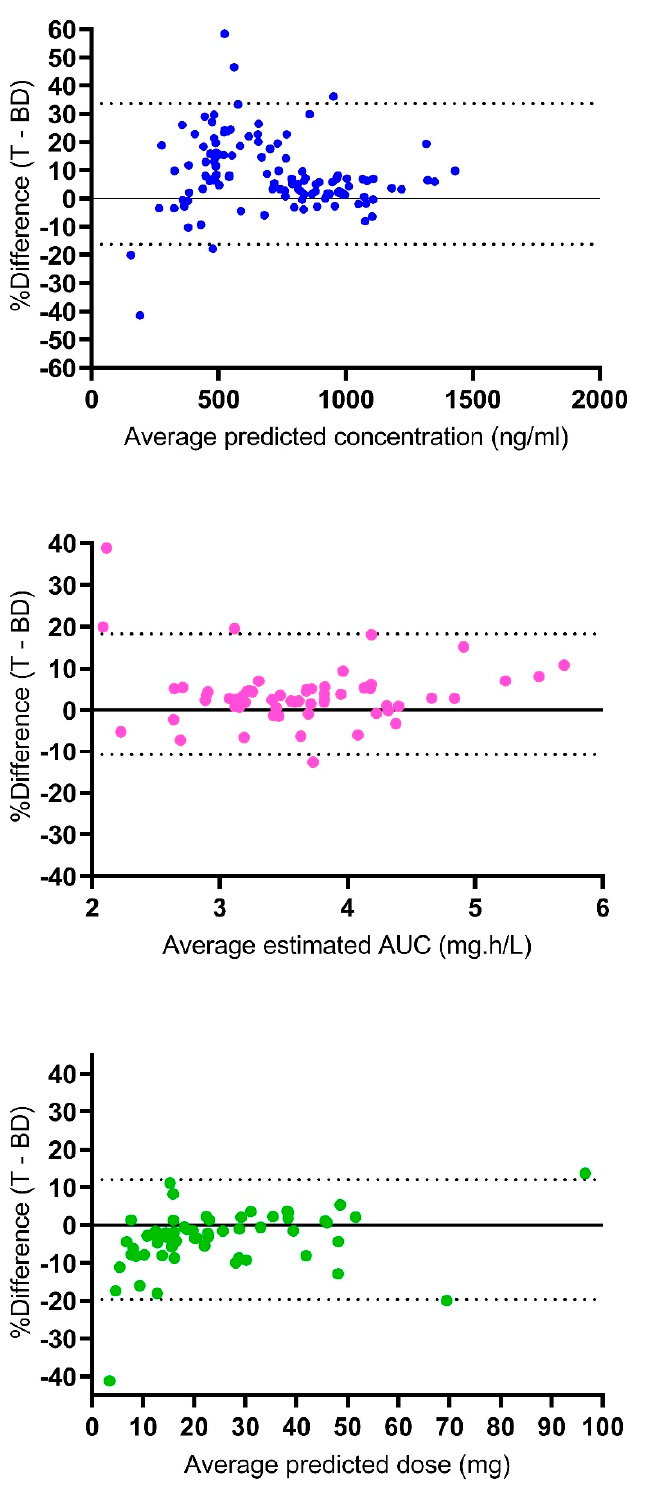
Figure 2. Bland–Altman plots of agreement between Tucuxi and BestDose results. Upper panel, agreement between predicted concentrations; medium panel, agreement between estimated AUC0–6; lower panel, agreement between predicted doses. The dotted lines are the 95% limits of agreement. The solid horizontal line is y = 0.